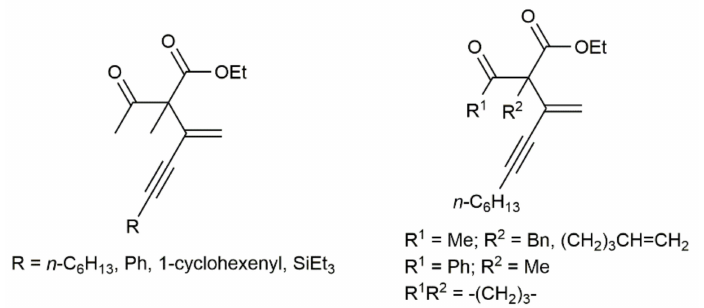
Figure 4. Products resulting from the In-catalyzed addition of β -keto esters to